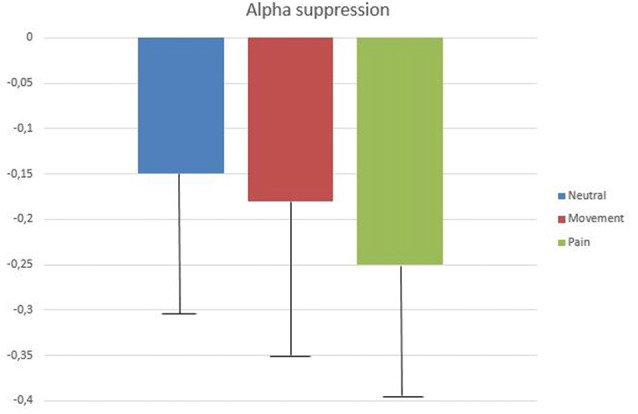
Mean log ratios (with standard deviation bars) of low alpha (8–10 Hz) amplitude difference between baseline (eye open, blue screen) and the three experimental conditions (neutral, movement and pain) at T7 (observation and empathic instructions).